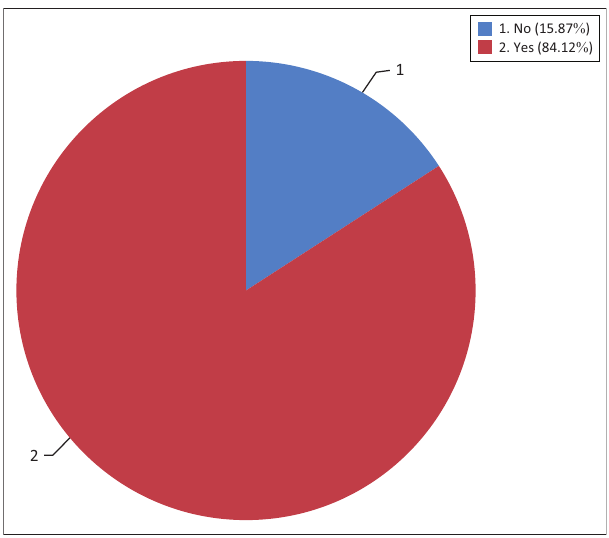
FIGURE 4: Farmers’ perception (%) on the impact of fall armyworm on maize varieties planted.